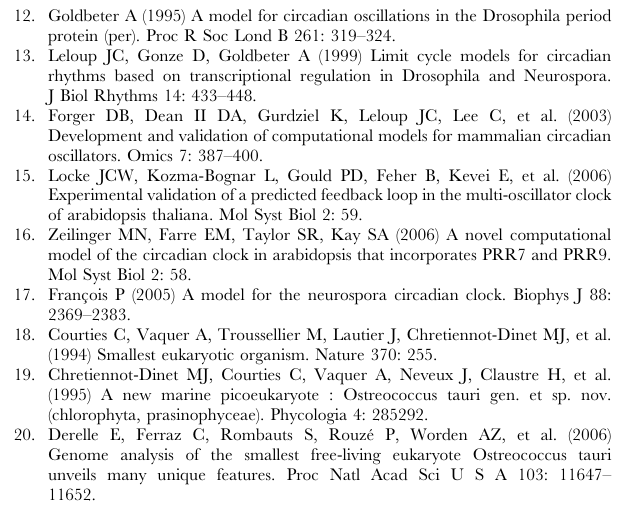
Figure S1 Transition from light/dark alternation(LD) to con- stant light (LL) and constant darkness (DD) for the fully coupled model. Time evolution of mRNA concentrations for the fully coupled model shown in Fig. , 2(A) for various light protocols: LD alternation (dashed, black), one LD period from ZT0 to ZT24 then constant light (in red) and one LD period from ZT0 to ZT24 then darkness (in blue). Cca1 and Toc1 mRNA concentrations are shown in the top and bottom frame, respectively. Figure S2 Influence of experimental errors on adjustement of a free running oscillator model to data. Alternate target profiles with samples randomly chosen inside the interval of variation observed are generated and adjusted. Each random target corresponds to a slightly different parameter set and to a different adjustment RMS error (A) RMS error distribution; (B) The five target profiles most distant from each other have been selected and are associated with different colors. Crosses (resp. circles) indicate the Cca1 (resp Toc1 ) mRNA target samples, the solid line is the numerical solution of the adjusting model. Figure S3 Probability distribution for parameter values in parameter sets with adjustment RMS error below 10%. Parameters are determined as explained in Methods. The percentage of occurrence is evaluated for bins of width 0.2 in log 10 . The probability distributions of parameter values for the model with all parameters modulated are shown in red and blue for the day and night values, respectively. The probability distribution of parameter values for the model with all parameters constant is shown in black. Figure S4 Characterization of coupling schemes. (A) iPRC characterizing the phase change induced by an infinitesimal perturbation of parameters l X , b X and K X . (B) Characterization of time position, t m , and duration t of couplings with a rectangular gating profile satisfying Eq. (1). Parameters are modulated either positively (red) or negatively (blue). (C) Characterization of time position and duration of couplings with a rectangular gating profile adjusting experimental data with a RMS error below $ 10% for four